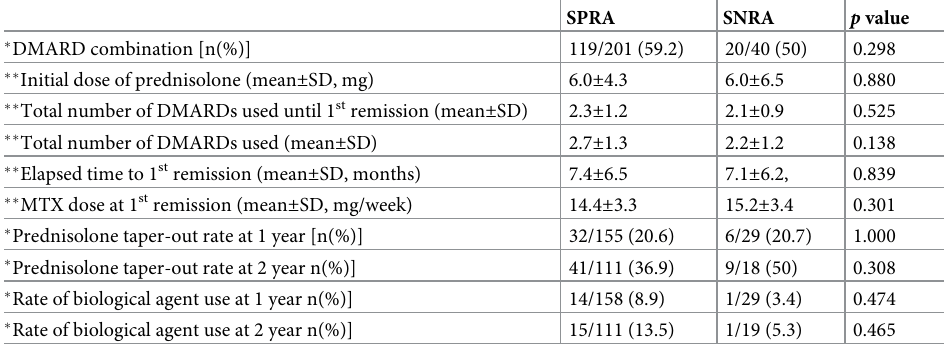
Table 4. Comparison of medication use between SPRA and